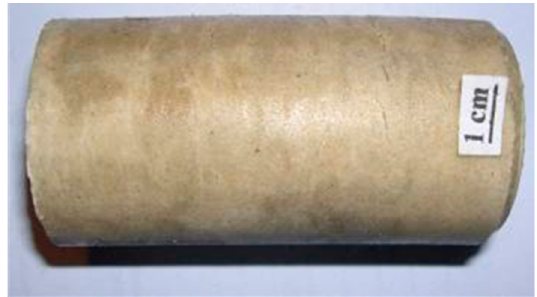
Figure 1. Frozen fine sand ‒ 2 with massive (dissemination) pore ice and CH 4 hydrate ( W = 10%; K h = 0.42) [18].